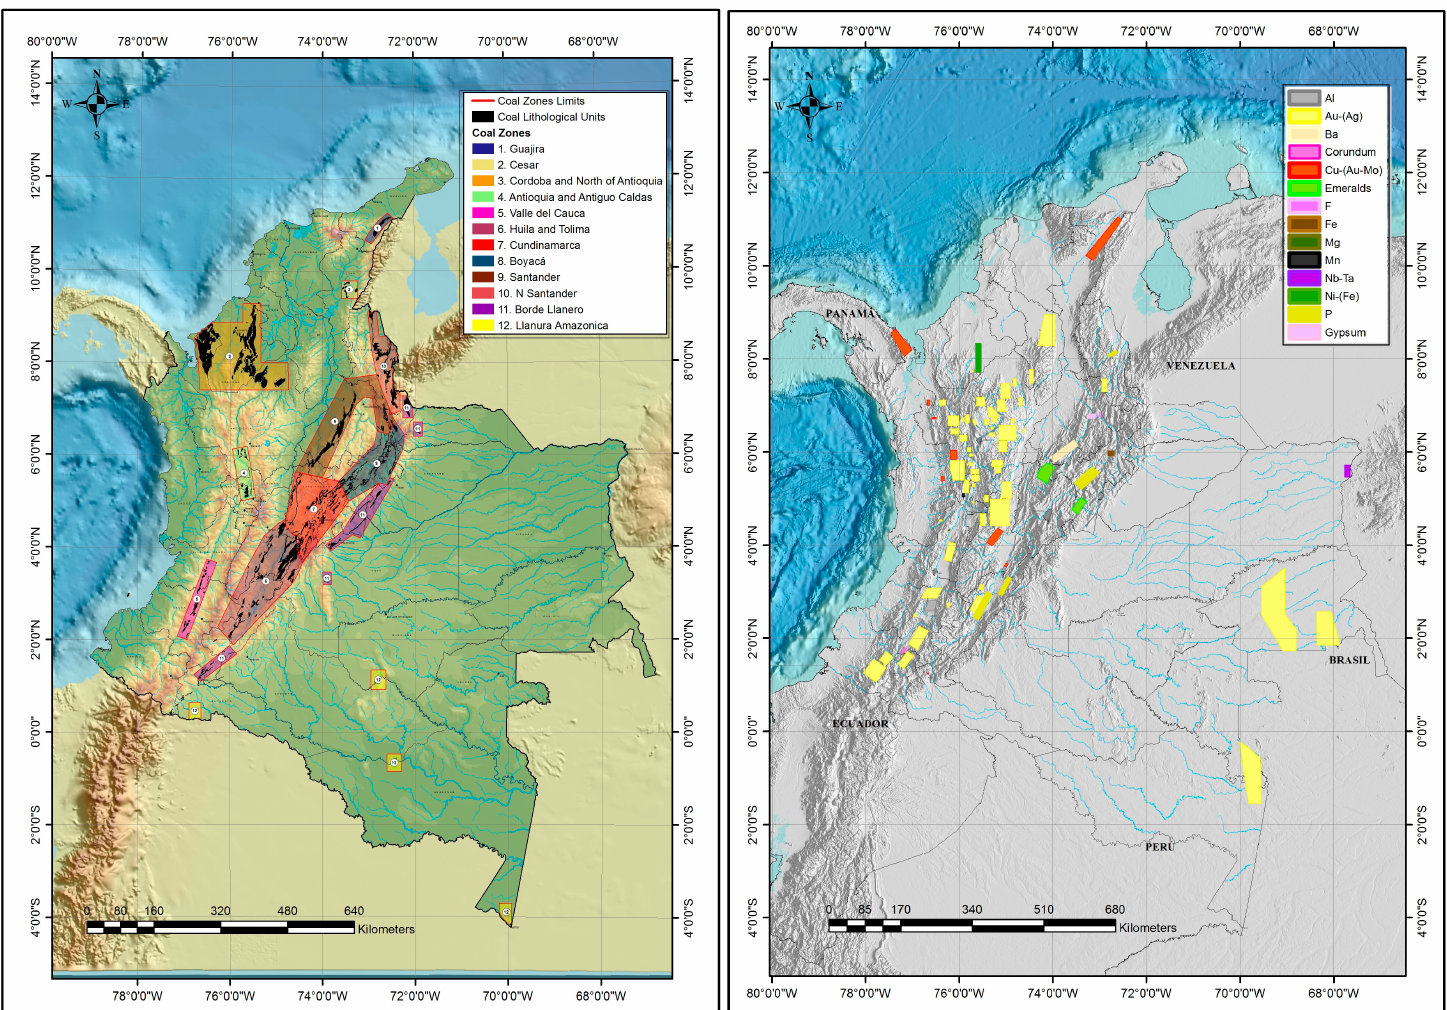
Figure 1. The main regions of coal and mineral reserves in Colombia (adapted from [7]).